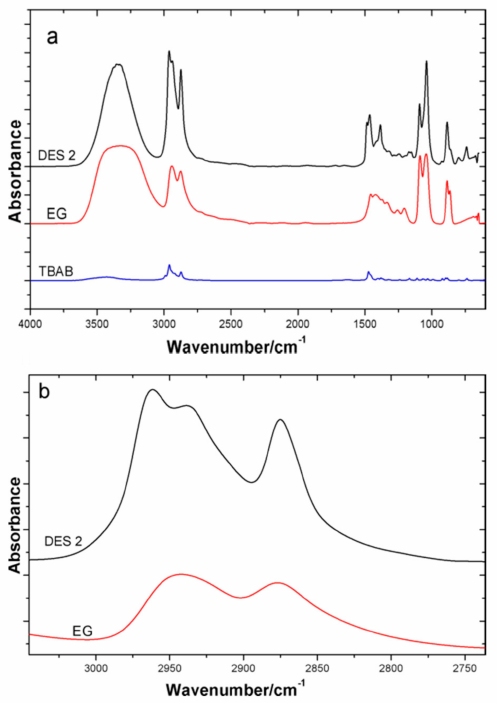
Figure 5. FT-IR spectra of TBAB, EG and DES2 (( a ), original figure, ( b ) local amplification